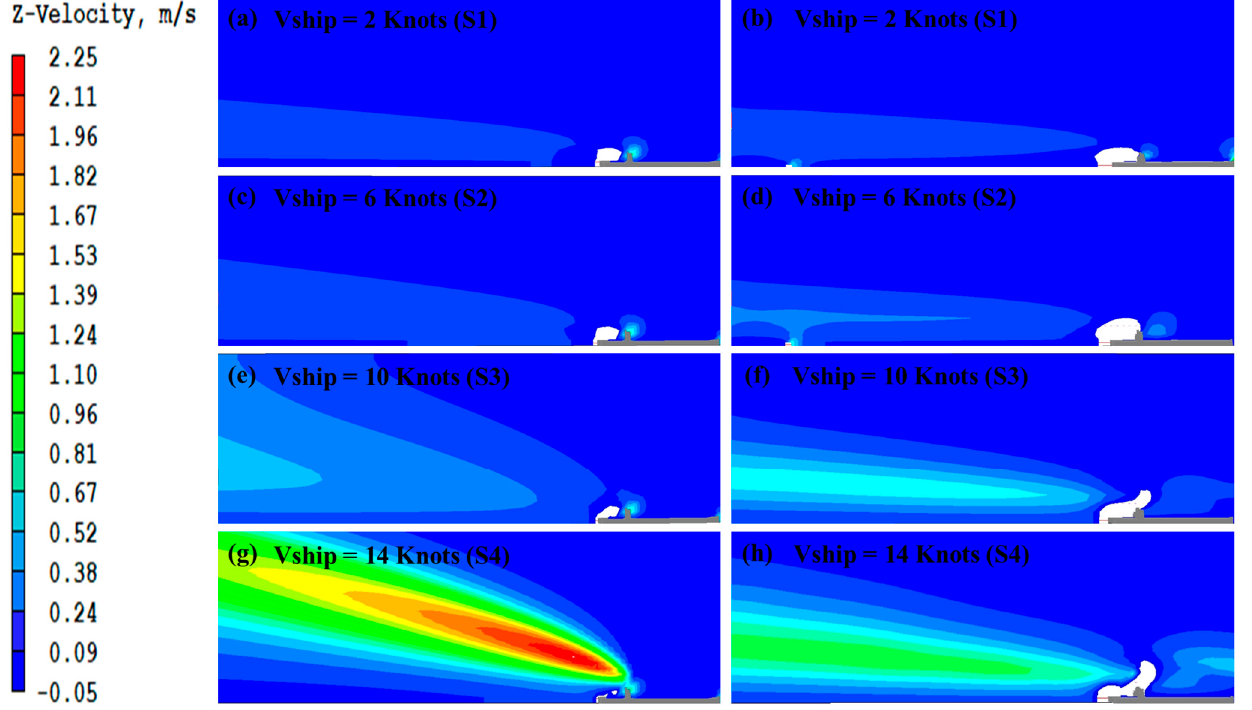
Figure 9. The vertical velocity contours in the V2 − T2 scenario with a wind speed of 3 m/s: ( a , c , e , g ) are the stationary sources and ( b , d , f , h ) are the moving sources.